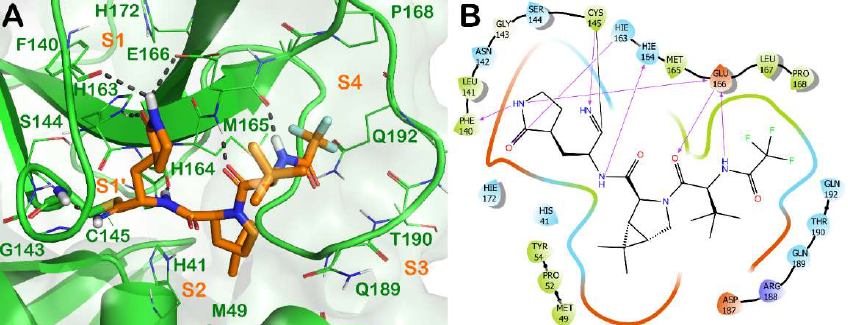
Figure 3. ( A ) Crystal structure of SARS-CoV-2 Mpro (green cartoon) in complex with the approved drug nirmatrelvir ( 3 ) (orange sticks) (PDB ID 7VH8). Interacting residues within the binding site are represented by lines, and the covalent bond established by Cys145 is represented by sticks. H bonds are illustrated by grey dotted lines. For the sake of clarity, water molecules are removed, and the complex was treated by the protein preparation wizard module available in Maestro